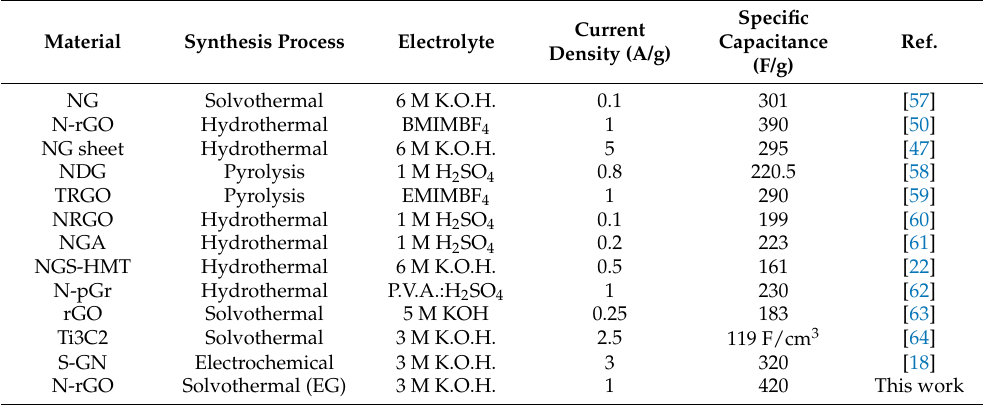
Table 2. Electrochemical performances of reduced graphene oxide-based electrodes made with various synthesis